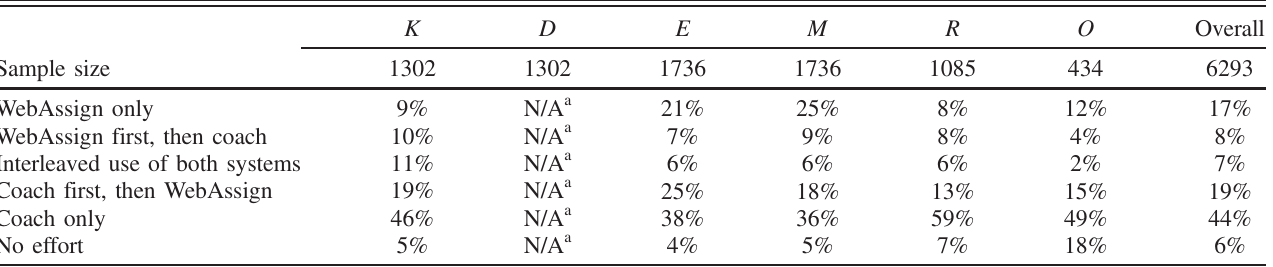
TABLE III. The percentage of homework problems in a given topic completed using a particular time order of using WebAssign and the computer coaches. Headings are defined in Table II. The overall figures exclude the dynamics coaches. The data come from the time stamps recorded by both the coach and WebAssign. The sample size is computed by multiplying the number of different homework problems for a topic by the number of students in the analysis